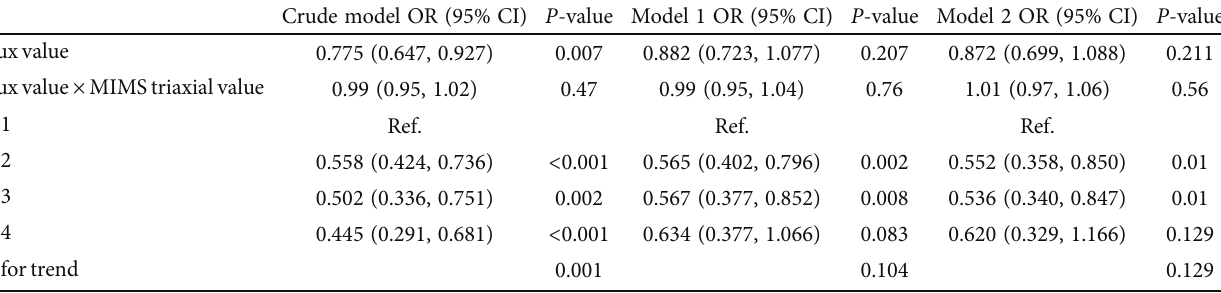
Table 2: Association of AI and cognitive impairment.